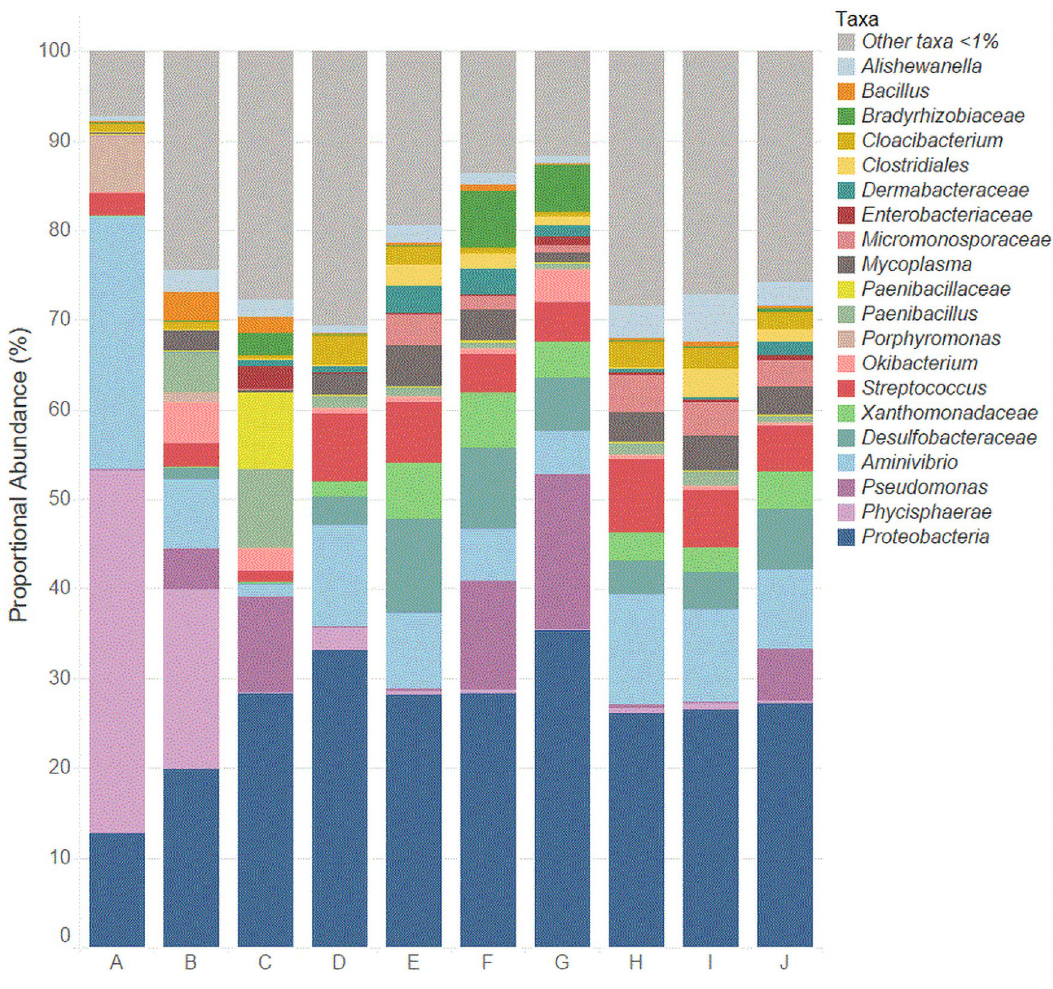
Fig 3. Relative abundance of unique taxa in the 10 brands of pine